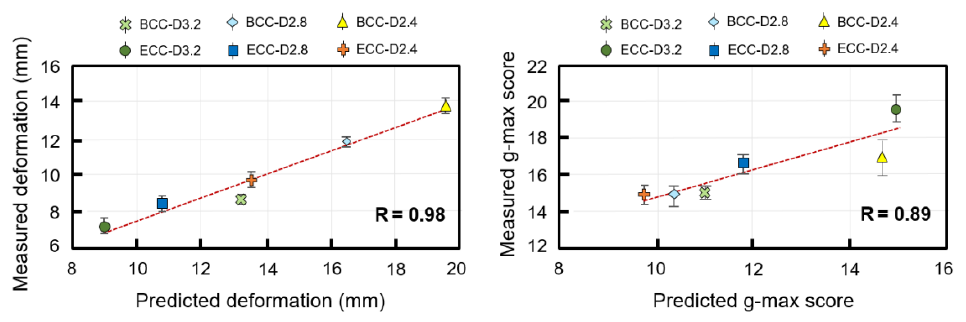
Figure 10. The relationship between experimental measurements and simulation predictions.